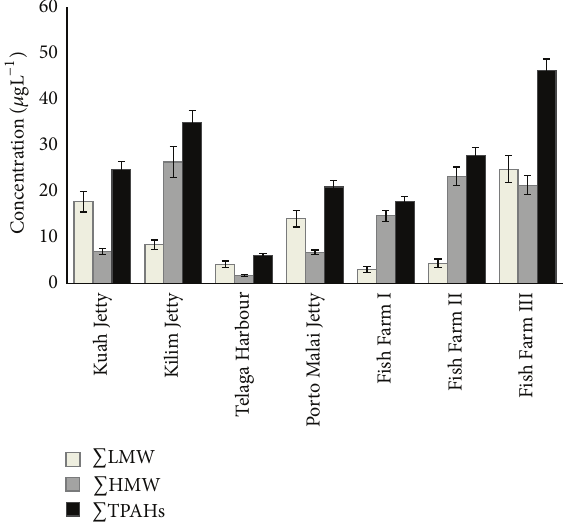
Figure 3: The total of HMW, LMW, and PAHs concentrations ( 𝜇 gL −1 ) in seawater from different sampling